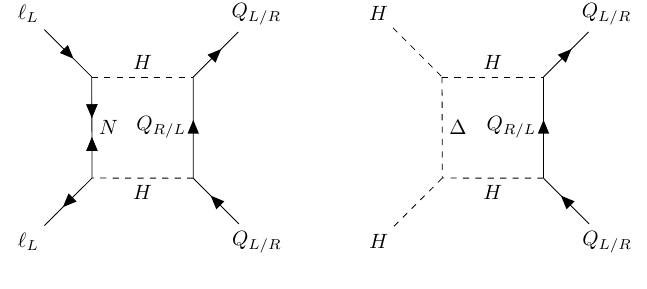
Figure 3 . Left: a diagram that contributes to the operator O lQ in type-I seesaw model. Right: a diagram that contributes to the operator O obtained by substituting one of the Higgs propagators for a gauge boson and adding one more Higgs